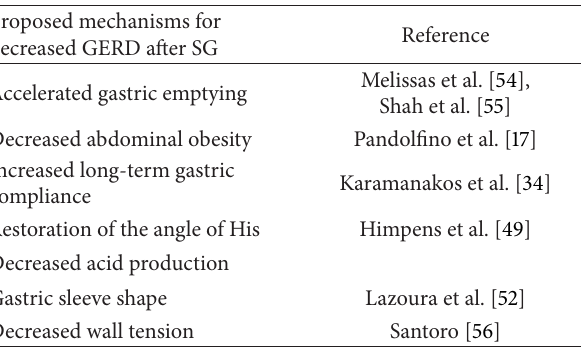
Table 4: Proposed mechanisms for a decrease in prevalence of GERD symptoms after